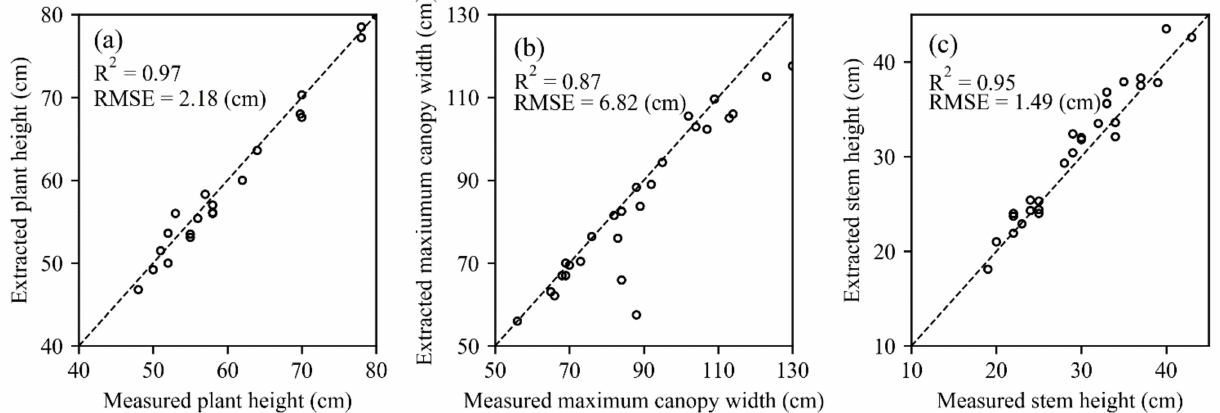
Figure 10. Relationships between the measured and extracted structural proxies of ( a ) plant height, ( b ) maximum canopy width, and ( c ) stem height.